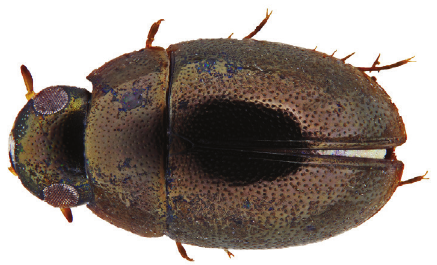
Figure 21. Paracymus pisanus Balfour-Browne, 1954 1.9 mm, iSimangaliso Wetland Park, False Bay (site 27), January 2015 DT Bilton, MS Bird & R Perissinotto